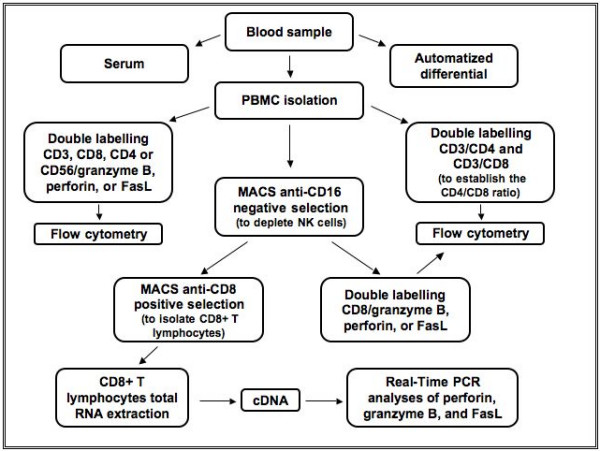
Blood processing protocol.